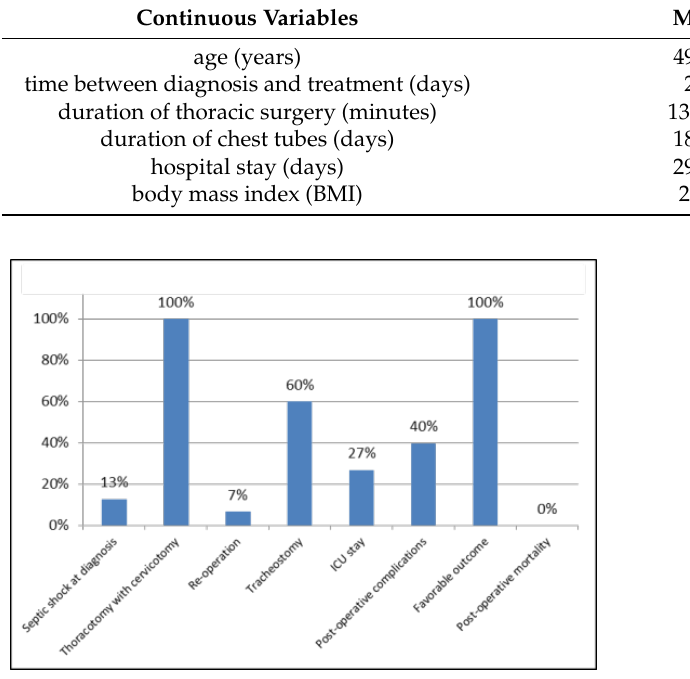
Figure 3. Data relating to the nominal variables, expressed as percentages.